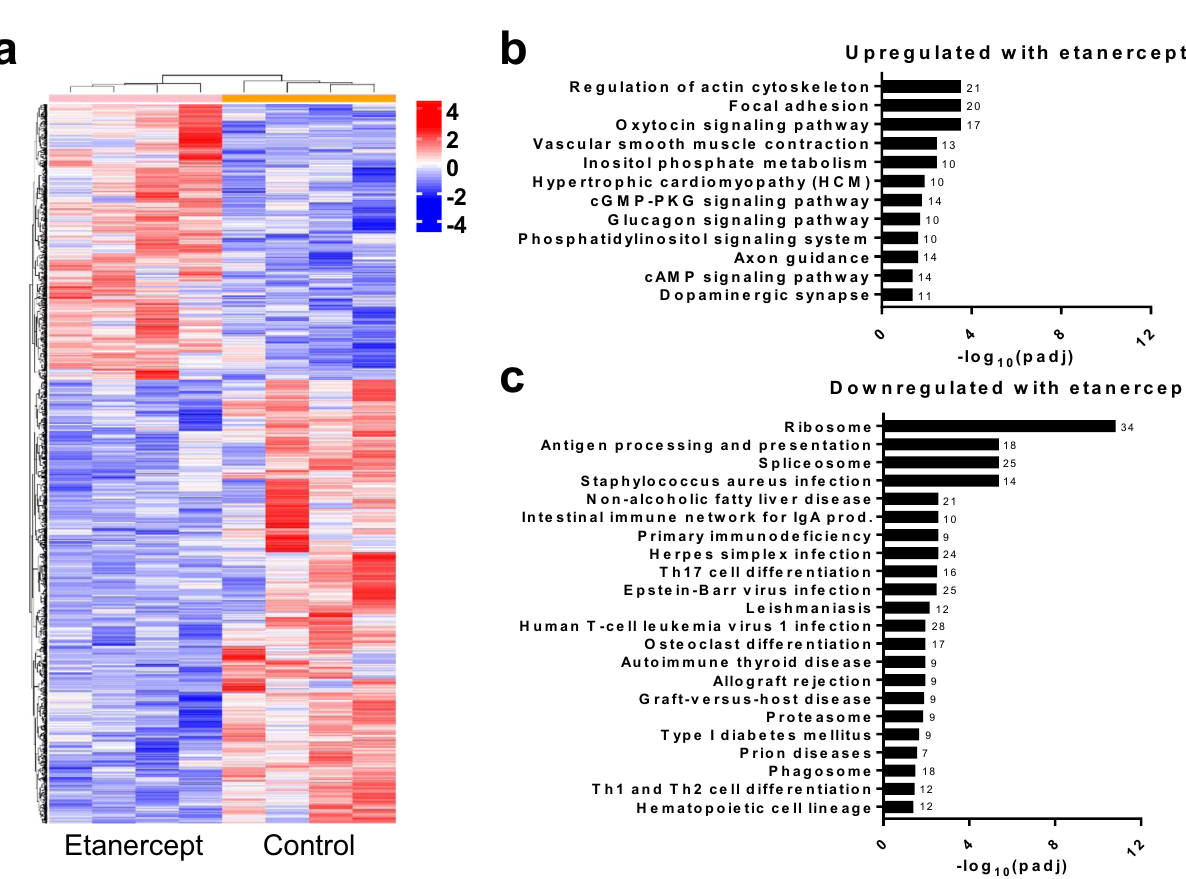
Fig. 5 Etanercept treatment induces pathway alterations in NOD prostate tissues. Bulk RNA-seq was conducted on the prostate tissues from control and etanercept-treated NOD mice (n = 4 per group) after fi ve weeks of treatment. a Hierarchical clustering of samples based on DE genes indicates separate clustering of the two treatment groups. Clustering analysis is carried out by log 2 (FPKM + 1) of union DE genes. Red color indicates upregulated genes and blue color indicates downregulated genes. b , c KEGG enrichment analysis using a one-tailed Fisher ’ s exact test identi fi ed signi fi cantly upregulated ( b ) and downregulated ( c ) pathways in response to etanercept treatment (adjusted p -value< 0.05). Numbers listed with each bar indicate the number of altered genes within each pathway. Source data are provided as a Source Data fi